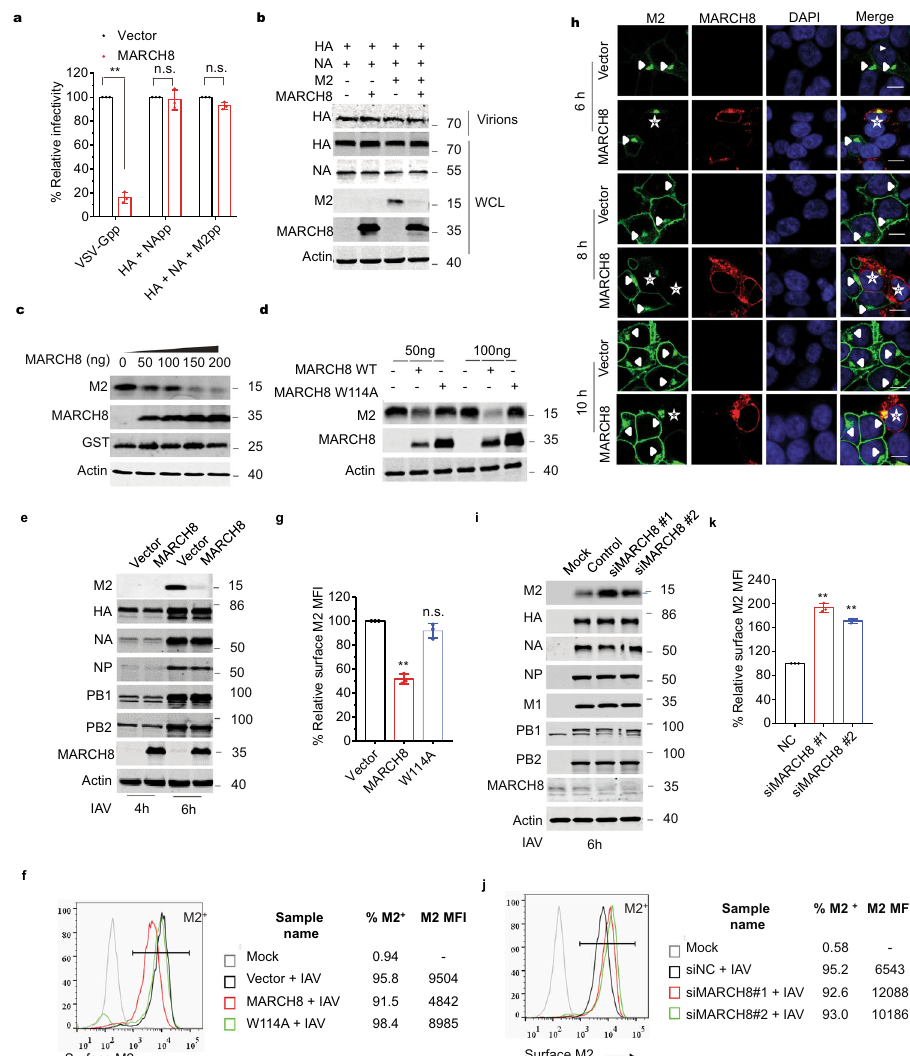
Fig. 1 MARCH8 downregulates M2 from the cell surface. a Infection of HEK293T cells with Lenti-GFP reporter viruses pseudotyped with VSV-G, IAV HA and NA or IAV HA, NA and M2 that were produced in control or MARCH8-expressing HEK293T cells. GFP-positive cells were scored with fl ow cytometry. b Production of Lenti-GFP reporter viruses pseudotyped with IAV HA and NA or IAV HA, NA and M2 in HEK293T cells without or with MARCH8, followed by western blot. c HEK293T cells were co-transfected with M2, Flag-tagged-GST, and increasing amounts of MARCH8, followed by western blot. d HEK293T cells were transfected with M2 and 50 or 100 ng of wild-type MARCH8 (WT) or the W114A mutant MARCH8 (W114A), followed by western blot. e – h HEK293T cells transfected with either a control vector or the MARCH8 were infected with WSN virus (MOI = 2). The cells were lysed for western blotting ( e ). M2 expressed on the non-permeabilized cell surface was measured by fl ow cytometry ( f ), and relative MFIs of surface M2 were shown in ( g ). Immunostaining of M2 and MARCH8 was shown in ( h ). M2 localization in control cells is indicated with arrows and in MARCH8-expression cells is indicated with stars. i – k HEK293T cells transfected with control siRNA or siRNAs against MARCH8 (siMARCH8 #1 and siMARCH8 #2) were cultured for 72 h, then infected with WSN virus (MOI = 2) for 6 h. The cells were lysed for western blotting ( i ). M2 expressed on the non-permeabilized cell surface was measured by fl ow cytometry ( j ), and relative MFIs of surface M2 were shown in ( k ). In a , g , and k , the values shown are normalized mean ± SD ( n = 3), ** P < 0.001, n.s., not signi fi cant, unpaired two-tailed Student t -test.